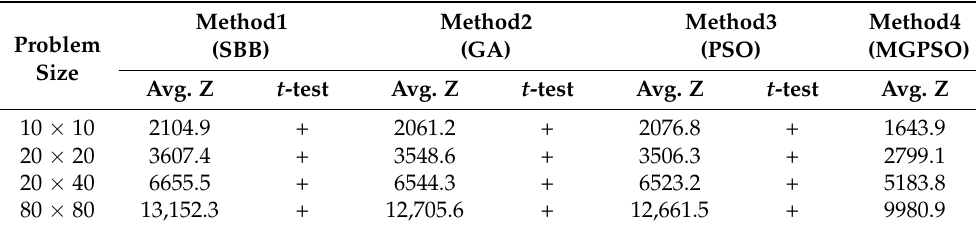
Table 9. Average Z -values and their t -test results obtained from the four approaches under different problem